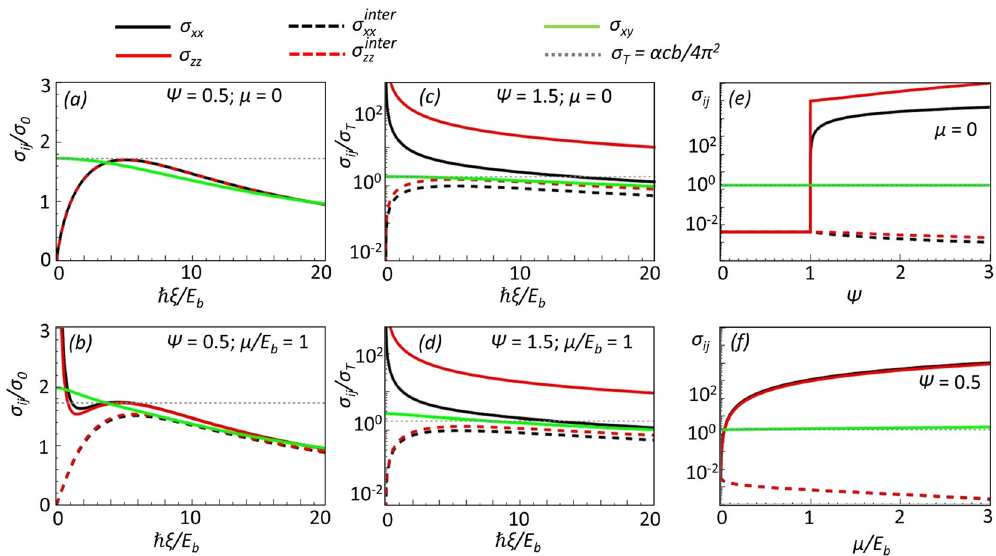
Fig. 3 Conductivity tensor components for type I and II Weyl semimetals at zero temperature and imaginary frequencies. Different contributions to the ¼ α _ c bulk conductivity components σ ij scaled by σ as a function of imaginary frequency ξ scaled by E b = ℏ v F b for: a Ψ = 0.5, μ = 0; b Ψ = 0.5, μ /E b = 1; 0 16 π _ v F c Ψ = 1.5, μ = 0; d Ψ = 1.5, μ / E b = 1. Different contributions to the bulk conductivity components σ ij,b scaled by σ 0 at ξ = 0 as a function of: e Ψ for μ = 0 and f μ /E b for Ψ = 0.5. The following parameters were used in the calculations: ϵ c = 10 eV, E b = 1 eV, c / v F = 300, Γ /E b = 10 − 3